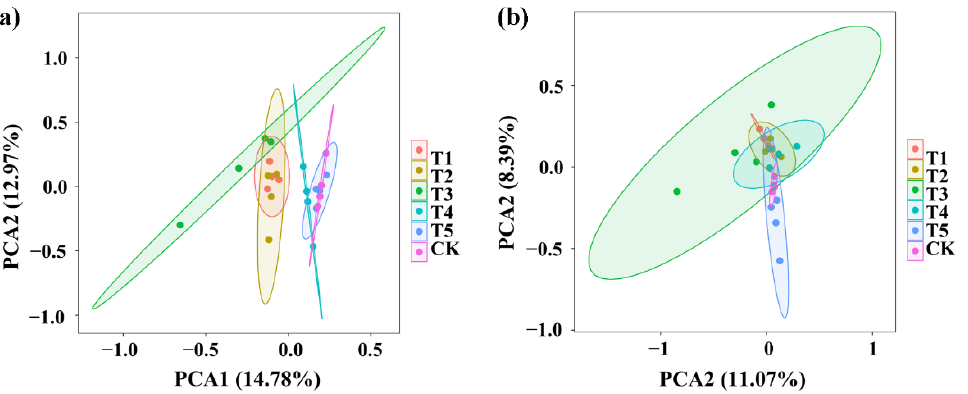
Figure 3. PCA results of soil bacteria ( a ) and fungi ( b ) based on OUT abundance. T1, T2, T3, T4, T5, and CK represent the treatment of Tuzangjin microbial fertilizer (TMF), carbonergic microbial agent (CMA), seaweed microbial fertilizer (SMF), sheep manure (SM), chemical compound fertilizer (CCF), and the control (CK), respectively.